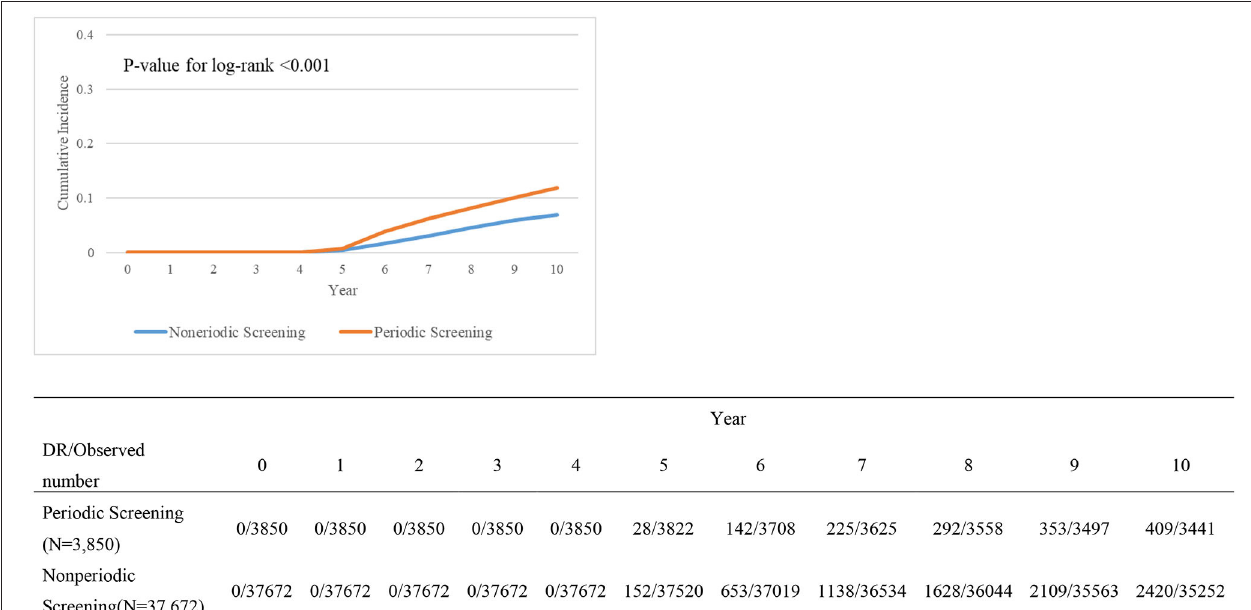
FIGURE 2 | Kaplan–Meier survival plot comparing periodic screening and nonperiodic screening